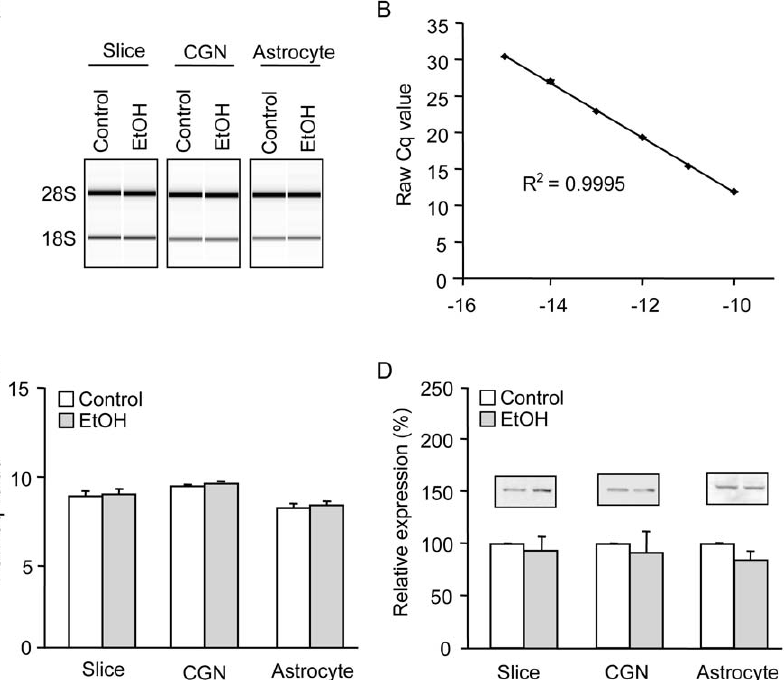
Figure 1. RNA quality, assay reliability, and validation of endogenous controls. Total RNA quality was assessed using an Agilent Bioanalyzer 2100 and endogenous controls were validated for RT-qPCR and Western blot. A) Generated gel images show representative slice, CGN, and astrocyte samples with and without 24-hr ethanol treatment. B) A standard curve was performed using a dilution series of purified L1 template. Increases in template concentration result in decreasing Cq values, as expected for a well-functioning qPCR assay (n=4). C) 18S Cq values are shown for all tissue/cell types with and without ethanol treatment. D) Representative Western blots for b -tubulin are shown for each sample type with and without 24-hr ethanol treatment. All bars (C, D) show the mean + SEM of 4 independent